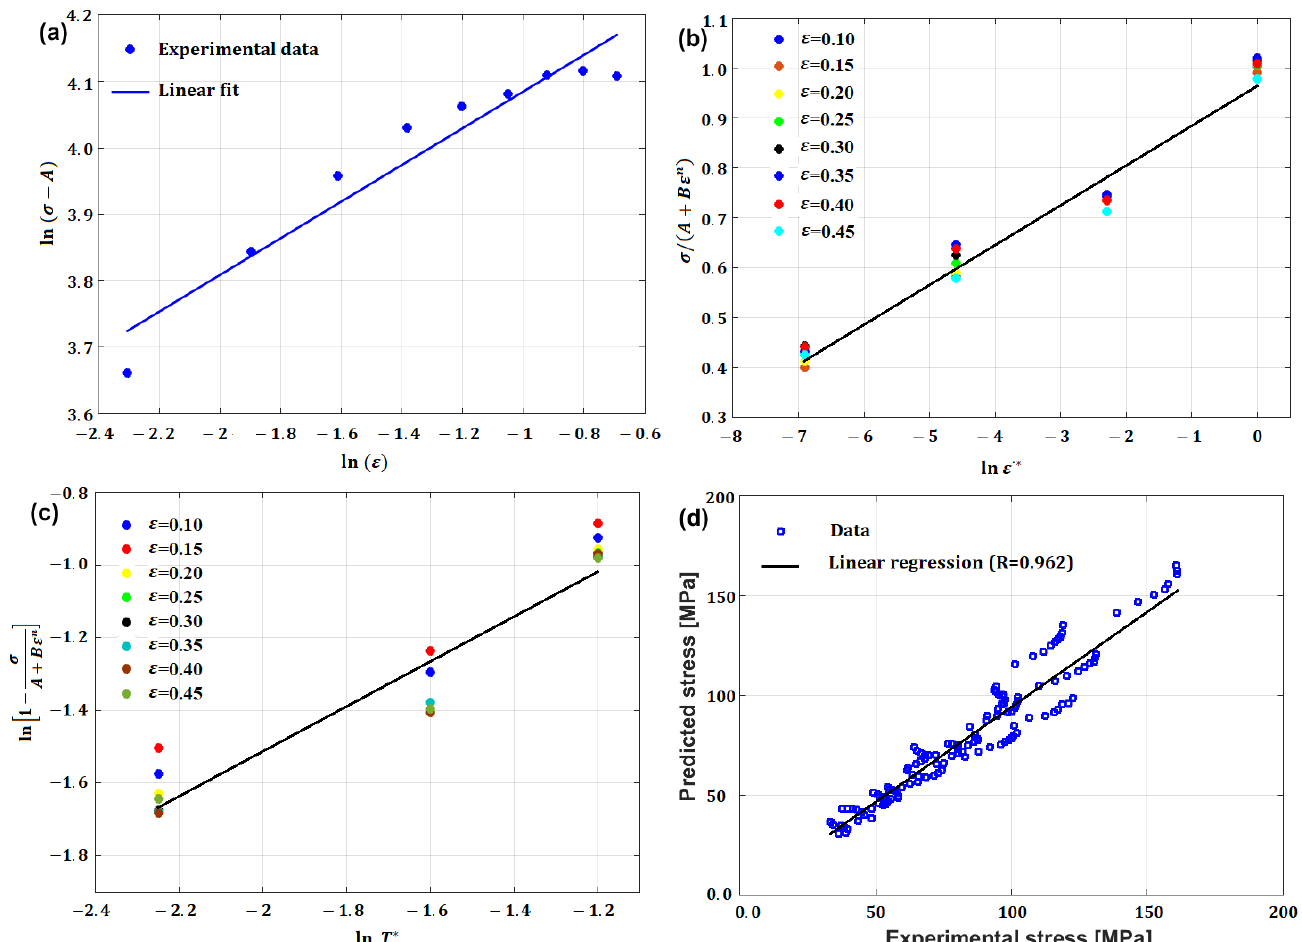
Figure 8. Determination of JC model constants for T24 steel alloy: ( a ) B and n; ( b ) C; ( c ) m; ( d ) correlation between experimental stresses and predicted stresses using JC model.